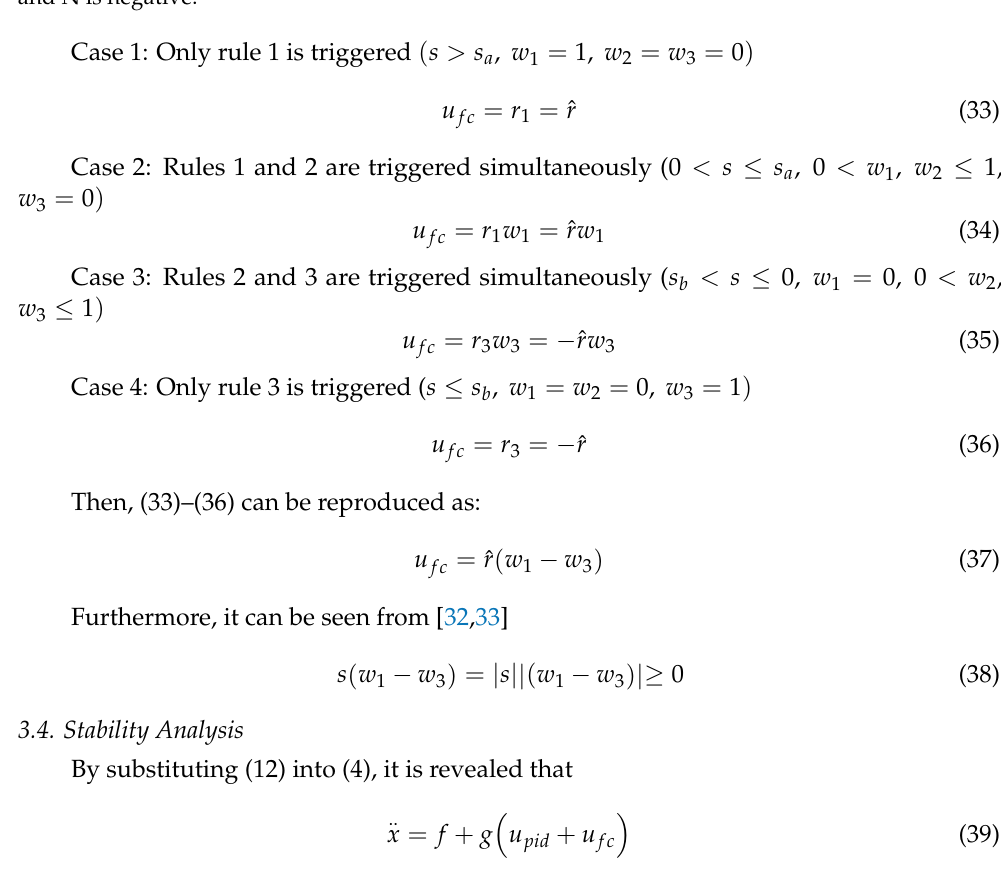
Figure 4. Membership function of ( a ) fuzzy input and ( b ) fuzzy output, where P is positive, Z is zero, and N is negative. and N is